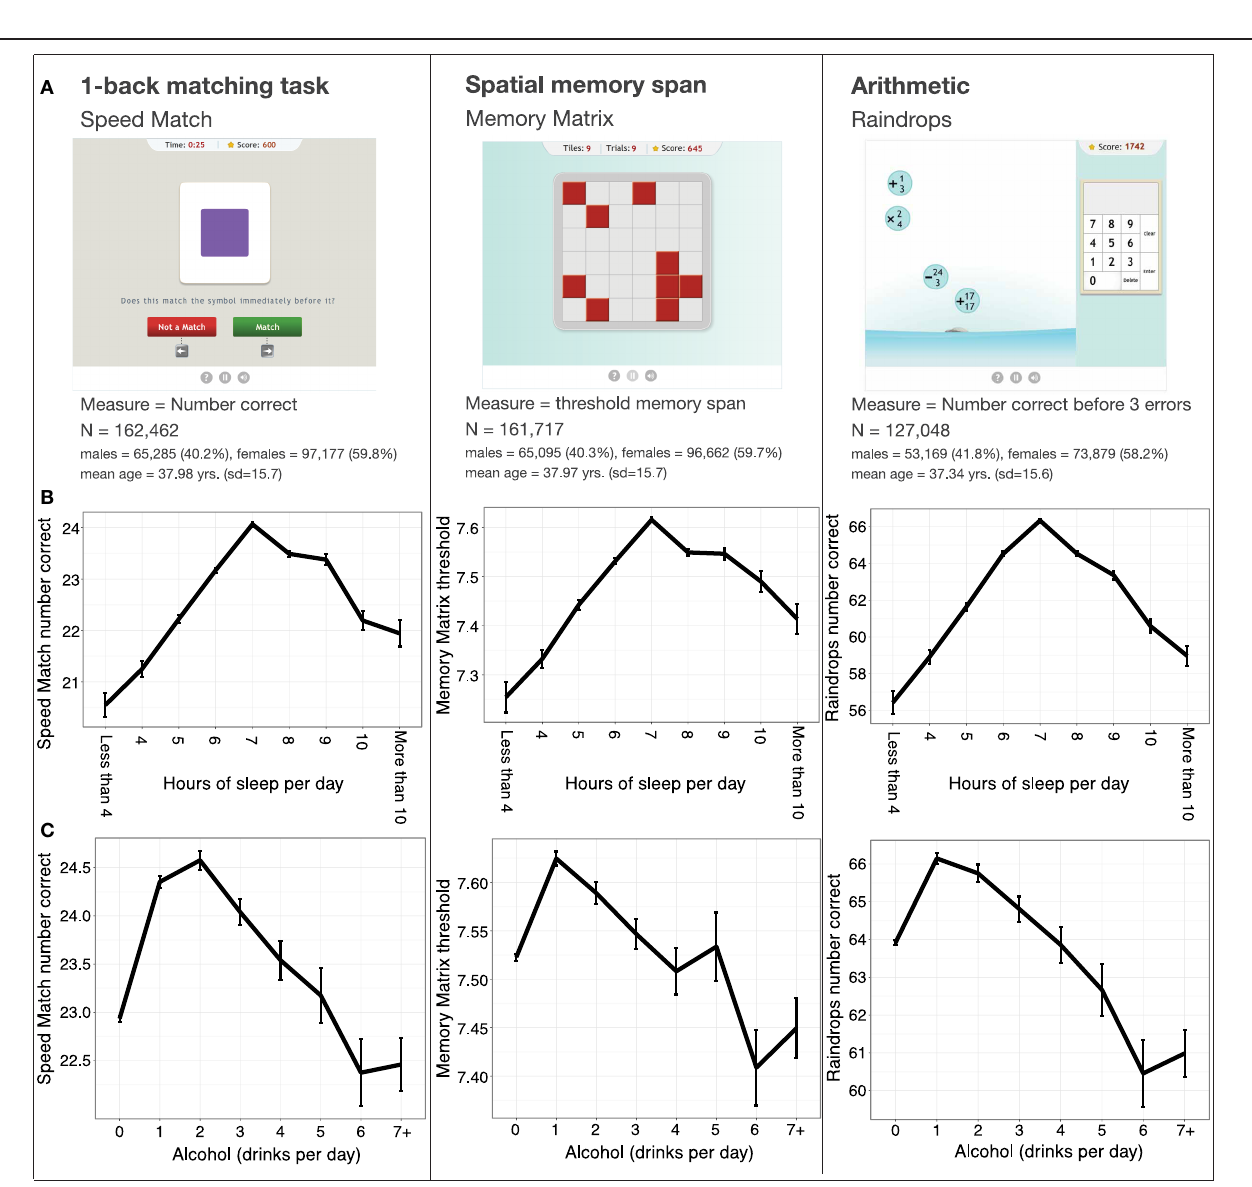
FIGURE 2 | (A) Exercises used in the analysis of the health and lifestyle survey. (B) The effect of reported sleep on game performance. (C) The effect of reported alcohol intake on game performance (controlling for age, gender, and level of education).